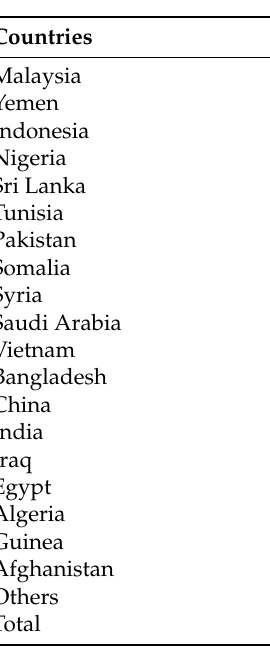
Table 1. List of countries and sample